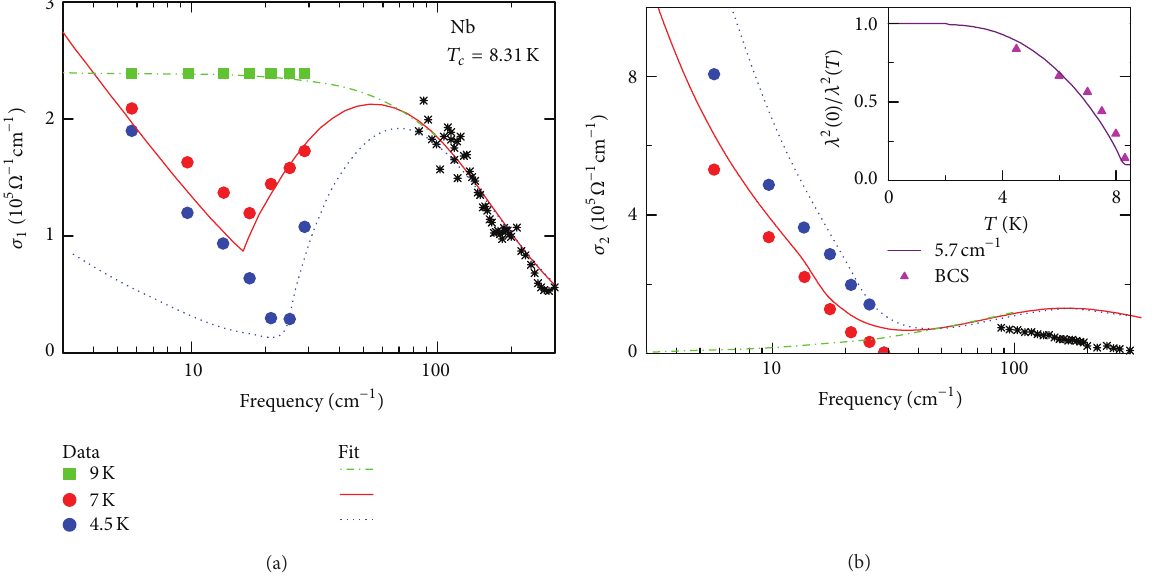
Figure 15: Frequency dependence of the real and imaginary parts of the conductivity, 𝜎 1 (𝜔) and 𝜎 2 (𝜔) , in niobium at various temperatures = 8.31 K. The transmission through a 150 ˚A thick film on sapphire was measured by a Mach- 𝑇 above and below the critical temperature 𝑇 𝑐 Zehnder interferometer; the stars were obtained by reflection measurements (after [97]). The lines are calculated using the theory of Mattis and Bardeen. The inset shows the temperature dependence of the penetration depth evaluated from the 𝜎 2 (𝑇) at the lowest frequency.